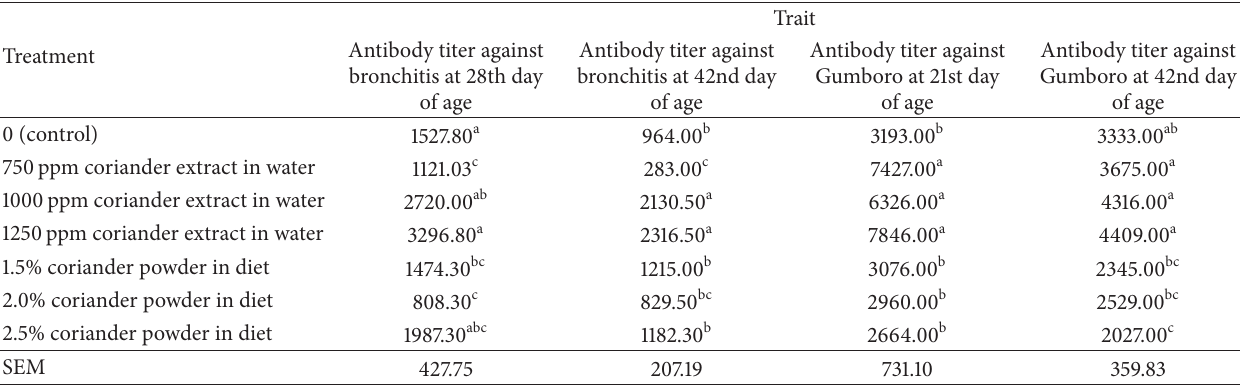
Table 10: Immunological responses against infectious bronchitis (IB) and infectious bursal disease/Gumboro (IBD) mean ( ± SEM) of Ross 308 broilers at starter, grower, and total periods of age fed diets or water containing the different levels of coriander ( Coriandrum sativum L.) powder and extract from 1 to 6 weeks of age (log 10 ) a,b,c